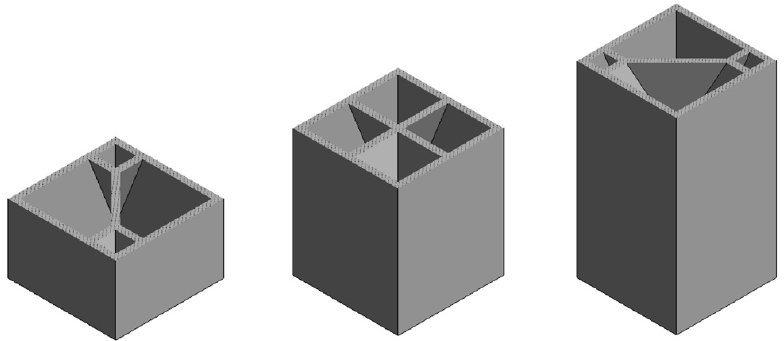
Figure 1. ( a ) Innovative cell geometry with internal diagonal walls; ( b ) cell cross-sectional view; and ( c ) two possible geometric honeycomb configurations, where the thickness of the external vertical walls is twice the thickness of the internal diagonal walls ( t ).